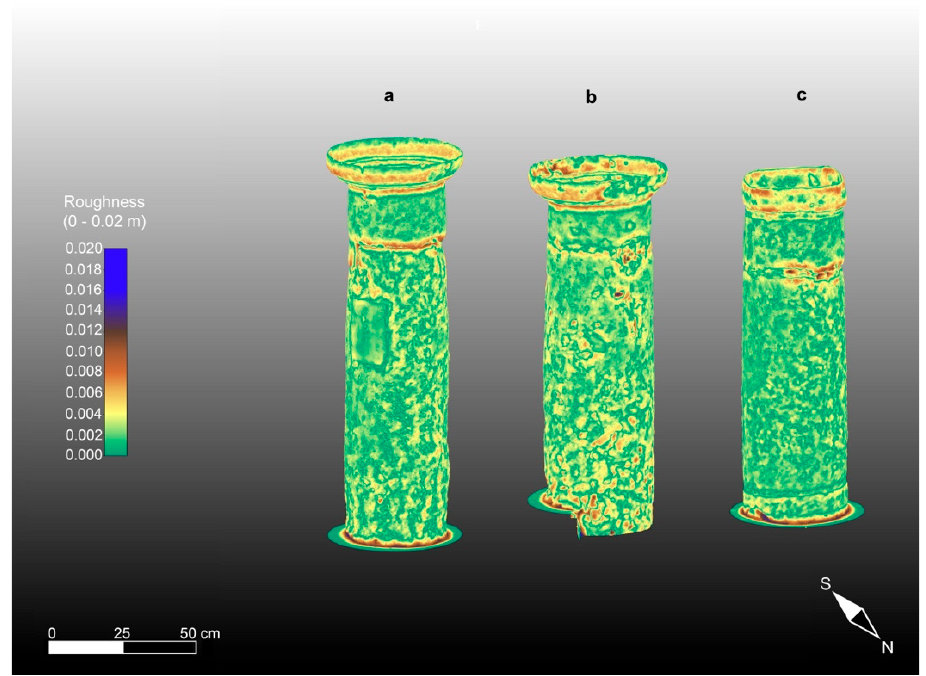
Figure 13. Roughness patterns of the three studied columns superimposed onto the 3D high resolu-